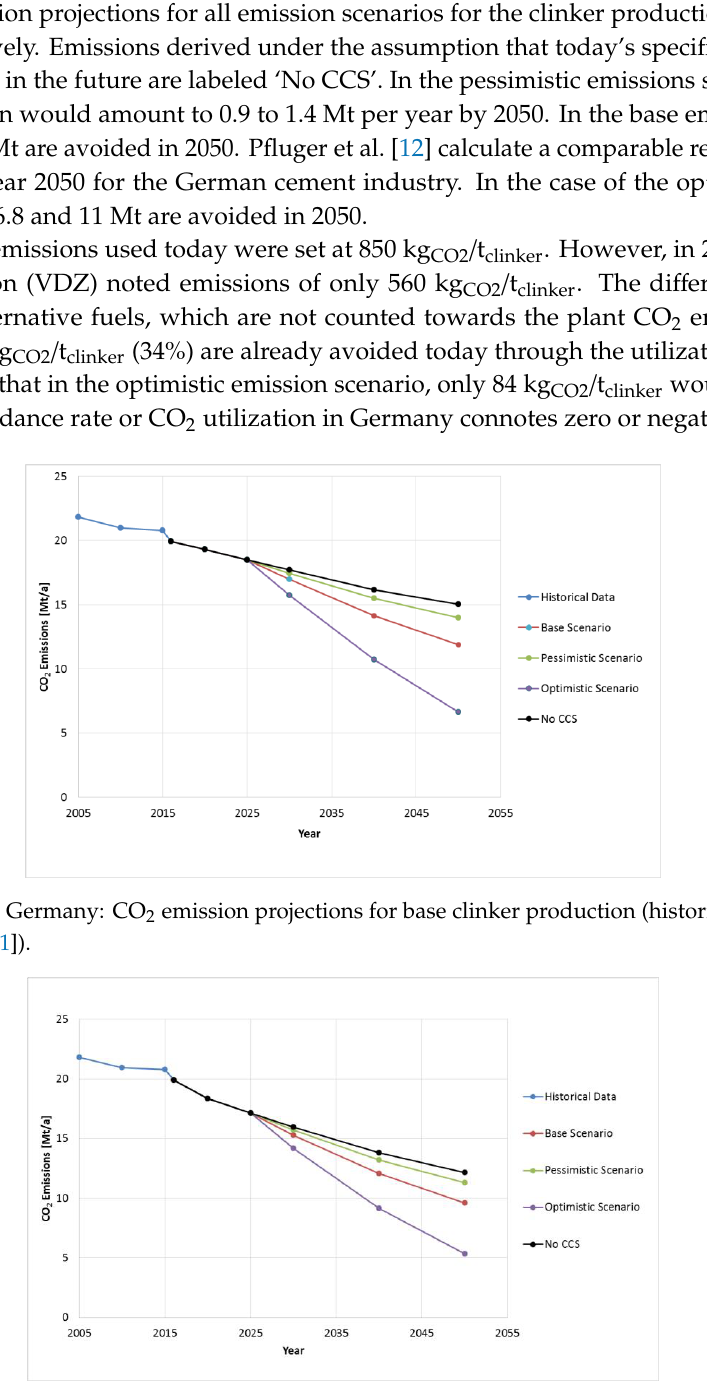
Figure 10. CCUS Germany: CO 2 emission projections for high clinker production (historical data from UBA/VDZ [21,51]). 5. Summary and Conclusions In this paper, a system analysis to explore post-combustion MEA absorption CCUS in the cement industry was carried out. The potential for reducing the industry’s CO 2 emissions was energetically and economically quantified. Furthermore, CO 2 emission projections for the clinker-producing industry and emission reduction potentials were derived for Germany. For CO 2 capture, steam supply plays a key role; four cases are assessed in the scenario analysis. In the base case and case 2, steam for supplying the reboiler heat demand is imported, and the associated emissions not captured. In case 3, steam is produced in an onsite coal boiler, and in case 4, steam and electricity are produced in a coal CHP. The boiler and CHP-associated emissions are captured in the post-combustion capture plant, too. The results show that the specific thermal energy requirement (3.5 – 3.8 MJ th /kg CO2 ), specific cooling demand (4.3 – 4.5 MJ th /kg CO2 ), specific compressor work (0.3 MJ el /kg CO2 ), and specific total work consumption (0.4 MJ el /kg CO2 ) only vary slightly across all cases. The same holds for the carbon capture costs, which amount to 63.6 EUR/t in the base case and 60.5, 60.9, and 54.4 EUR/t in cases 2, 3, and 4, respectively. For the CO 2 avoidance costs, however, the investigated cases show a significant difference. While in the base case and case